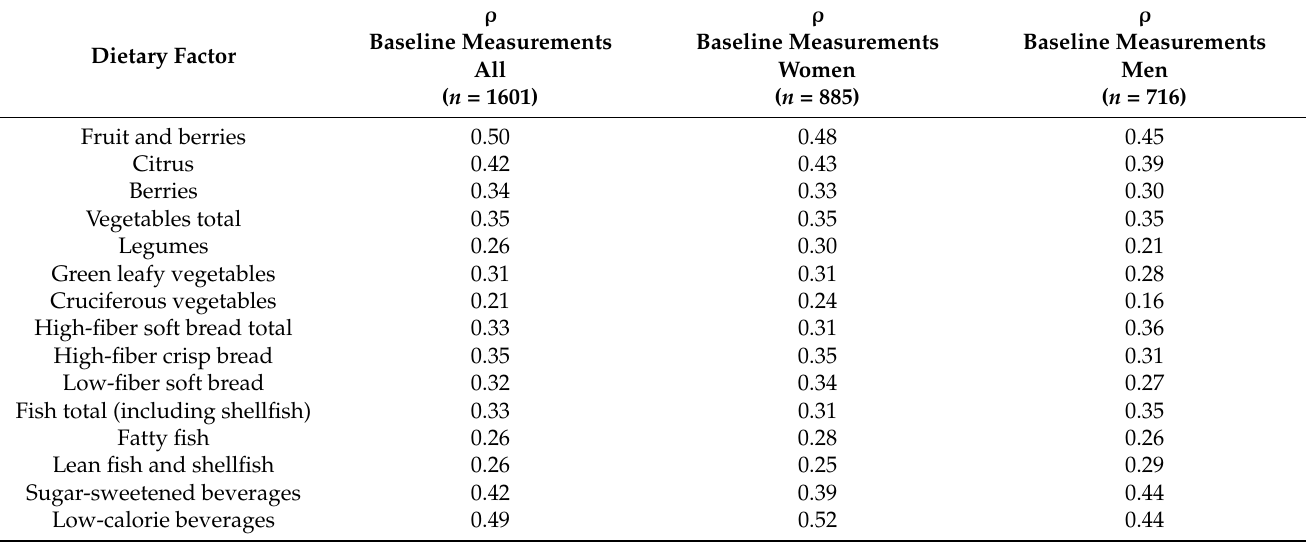
Table 2. Spearman correlations * between food intakes assessed by the 4-d food record (4DFR) (g/d) and the short food frequency questionnaire (SFFQ) (times/month and g/d for fish intake), in 1601 women and men from the Malmö Offspring